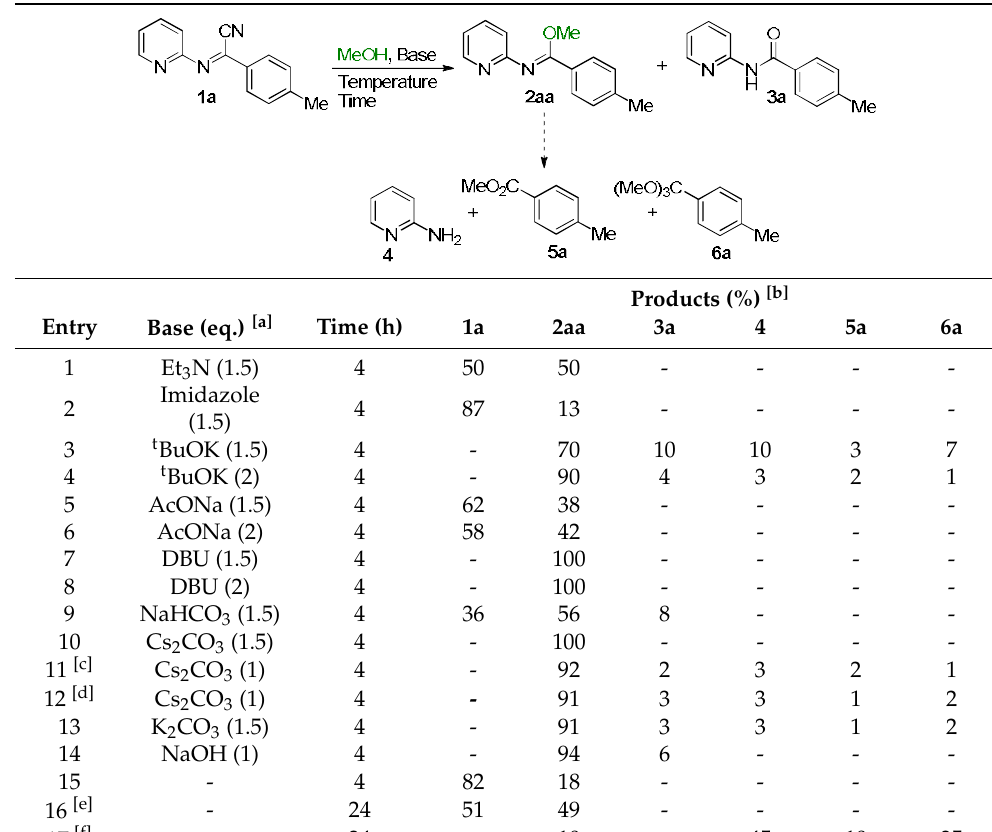
Table 1. Conditions and different bases evaluation for the transformation of 1a to 2aa in the presence of MeOH.